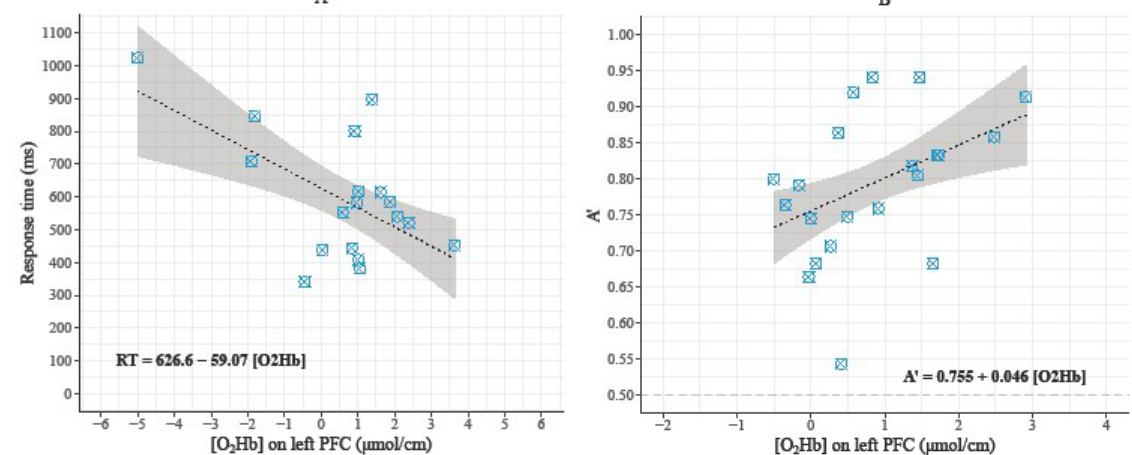
Figure 4. Scatter plots of the robust regressions where {O 2 Hb} in the left PFC predicted behavioral performance in young adults ( A ) and high-fit older adults ( B ) during the 3-back condition. The grey frame represents the 95% confidence intervals.